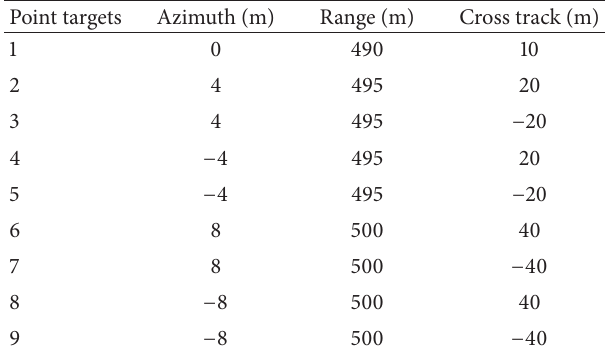
Table 2: The position parameters of the point targets.